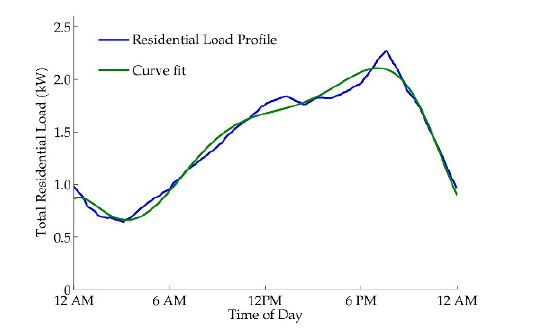
Figure 7. Residential load profile on a summer weekday